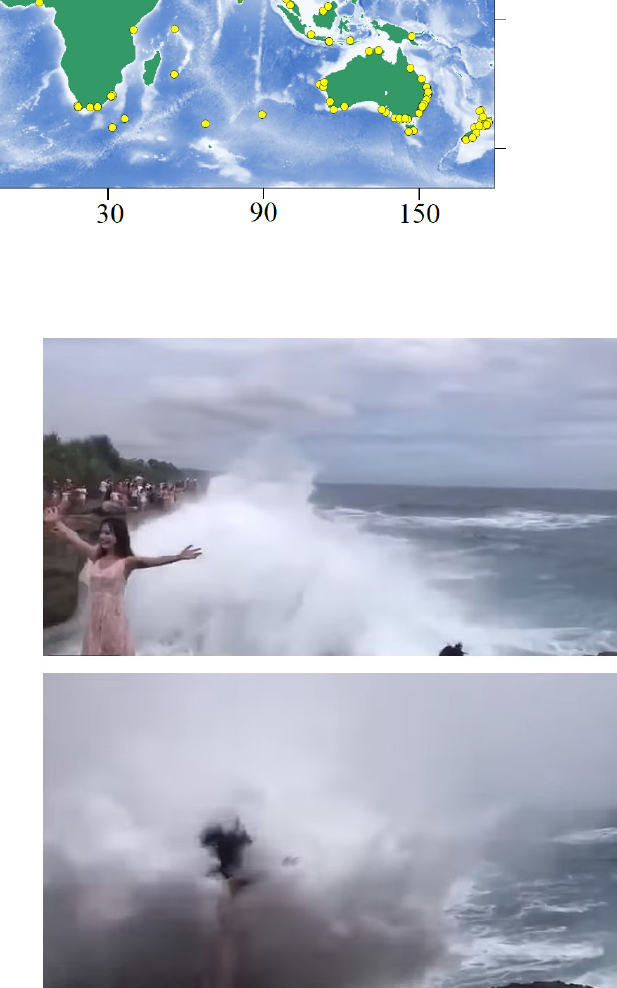
Figure 3. A person was almost swept out to sea from the cliff by a freak wave in Bali, Indonesia, on 17 March 2019